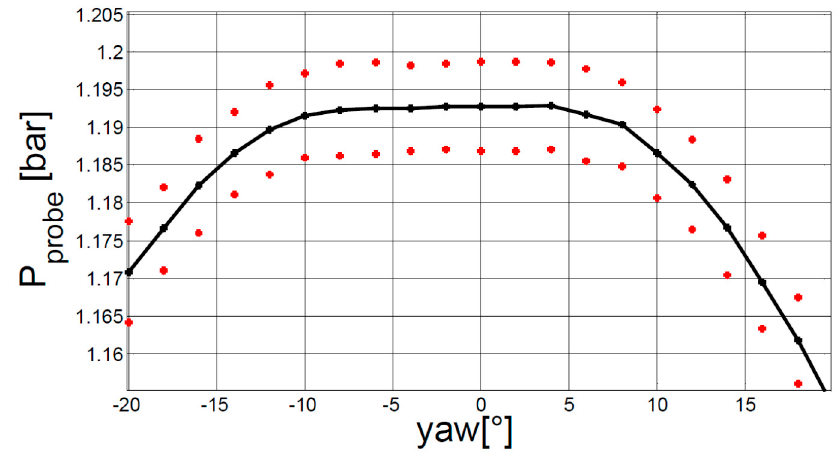
Figure 6. Uncertainty range for a test with a Mach number equal to 0.5.